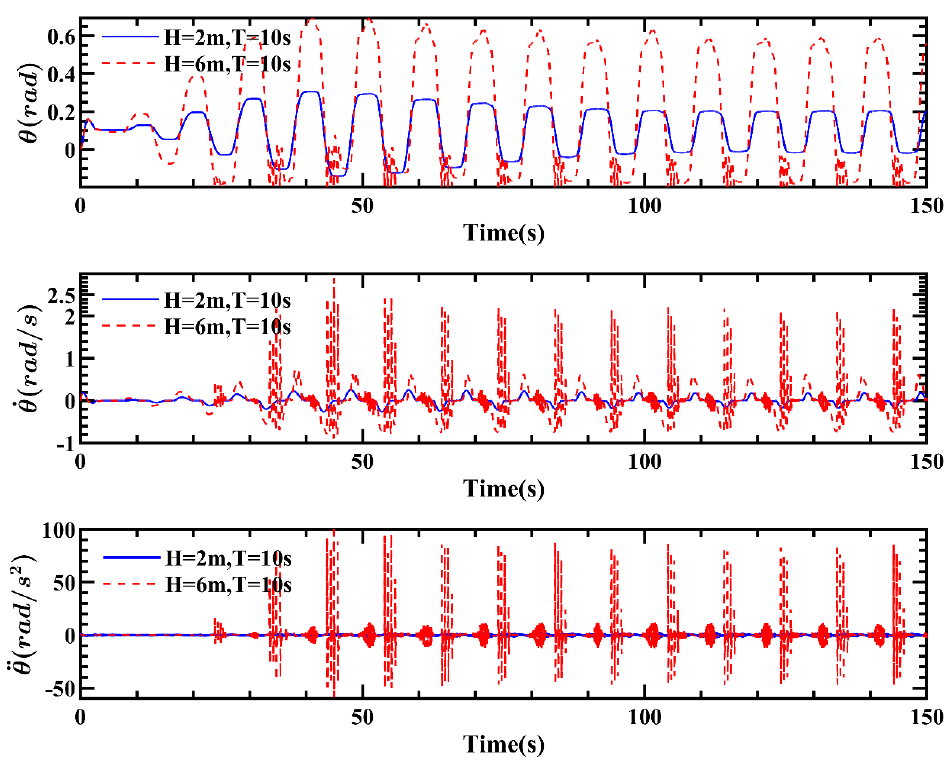
Figure 5. Self-locking response of S-PWEC.